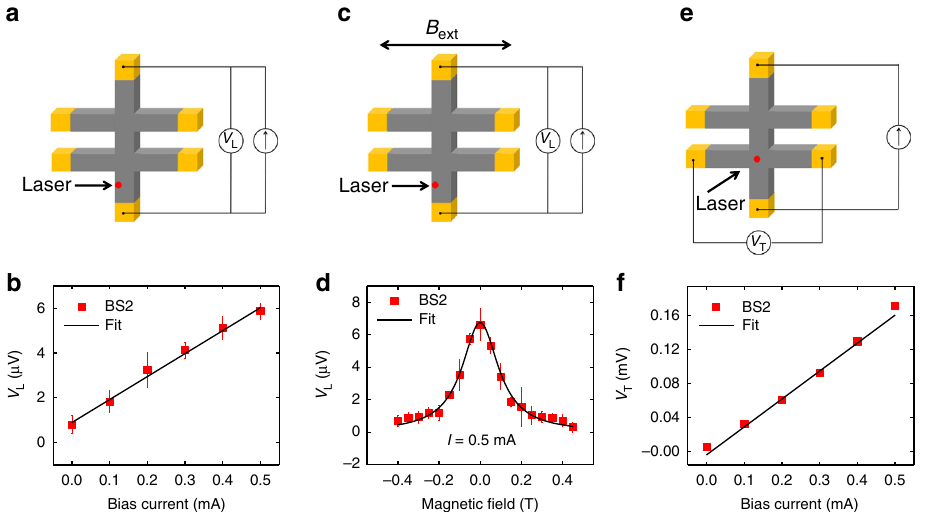
Fig. 3 Current dependence of the spin accumulations in Bi 2 Se 3 . a Experimental geometry of longitudinal photovoltage ( V L ) measurement. b Bias current dependence of V L by fi xing the laser spot at one edge of the device in BS2. c Experimental geometry of Hanle measurement. d Measurement of HDP at one edge as a function of in-plane B ext in BS2. e Experimental geometry of transverse photovoltage ( V T ) measurement. f Bias current dependence of V T by fi xing the laser spot at the center of the Hall cross in BS2. Solid lines are fi ts. The error bars in b , d , and f are the standard deviation from fi ve